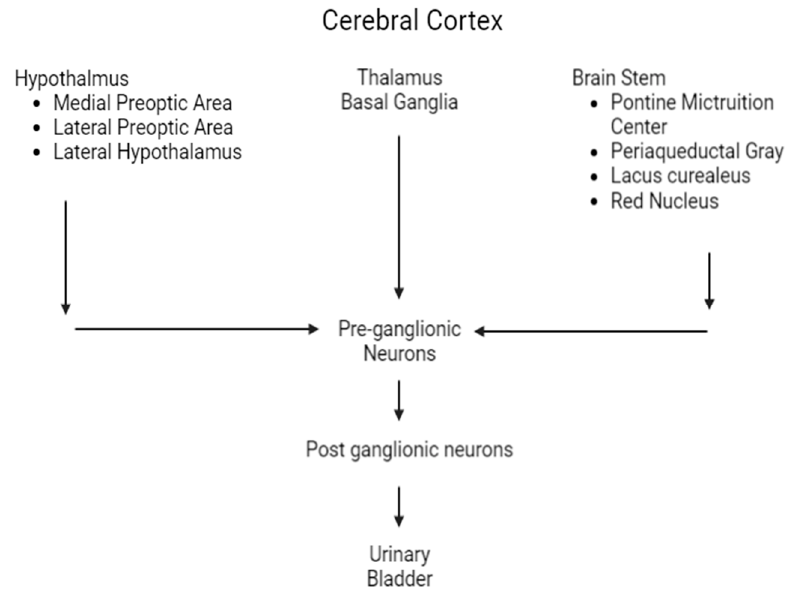
Figure 3. Brain structures involved with